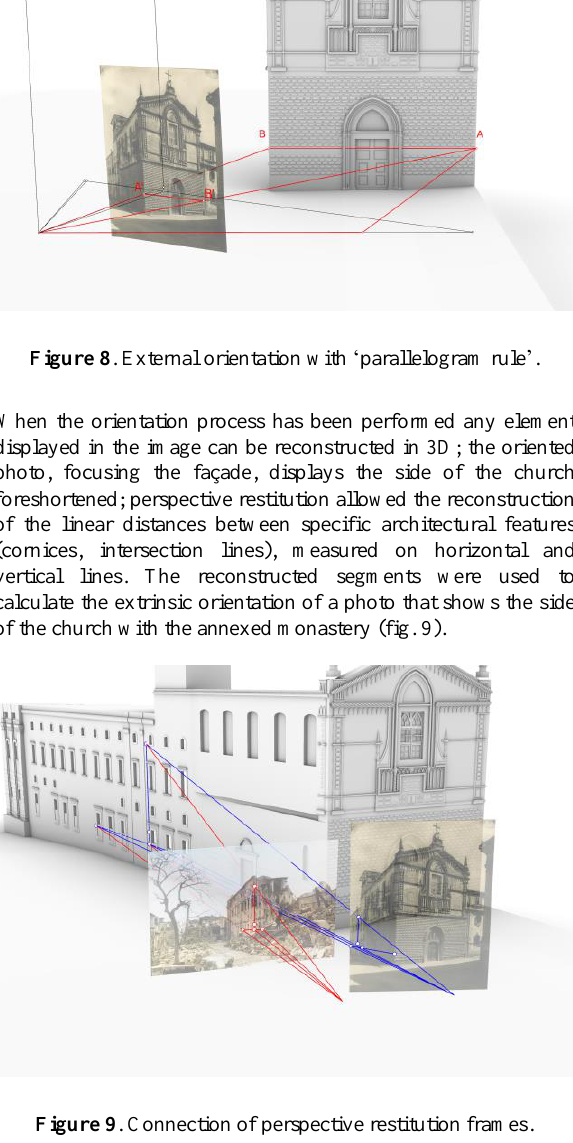
Figure 9 . Connection of perspective restitution frames.